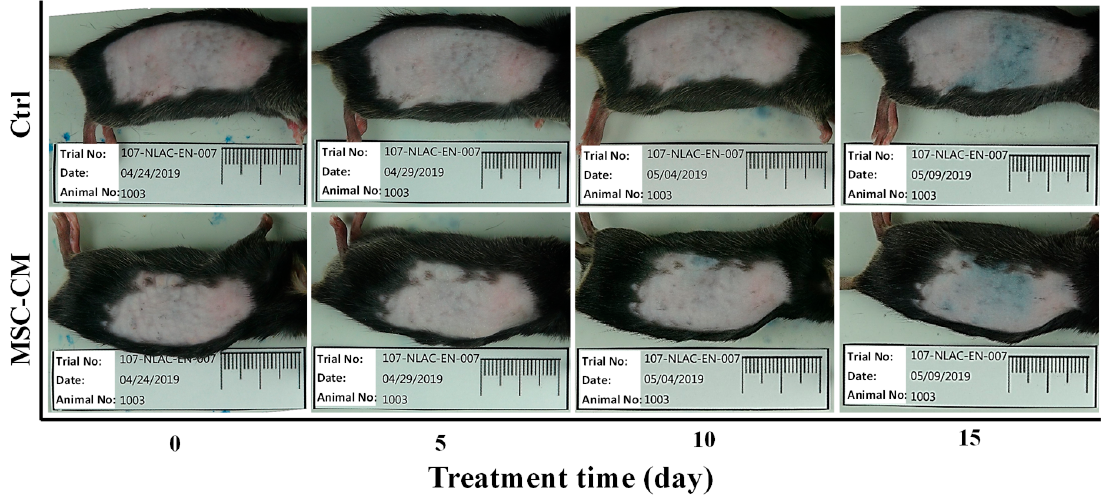
Figure 5. Animal models presenting the shaved skin of the mice after respectively being smeared with the vehicle and MSC-CM, from day 0 to day 15 of observations.